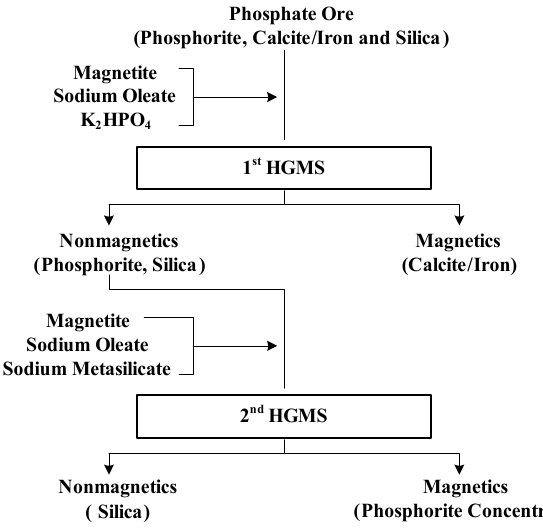
Figure 3. Schematic flowsheet of high gradient magnetic separation for Rajasthan and Madhya Pradesh rock phosphate [19].